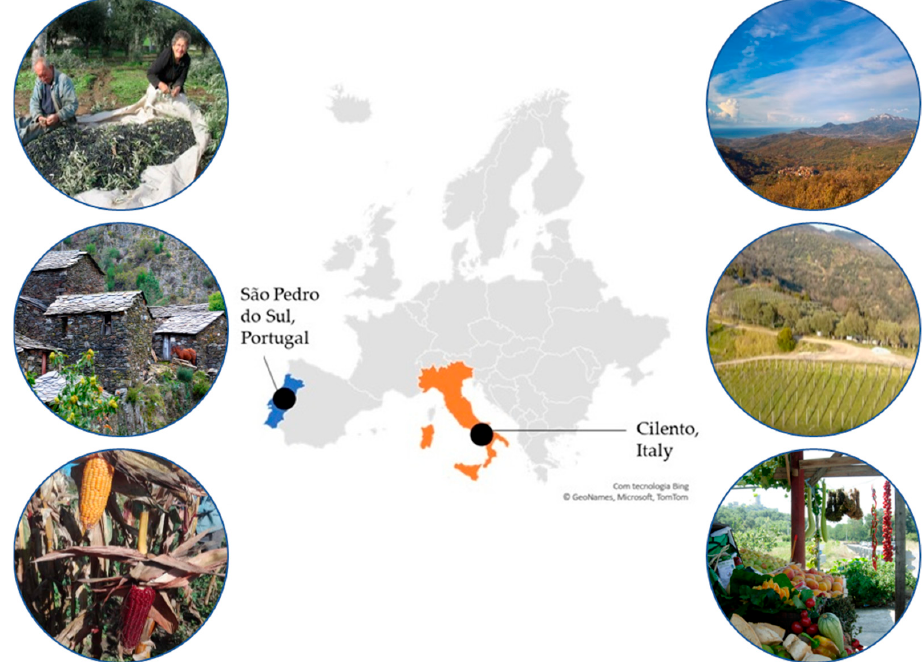
Figure 1. Cultural, technical and environmental diversity in two European Eco-regions—Cilento, Italy and São Pedro do Sul, Portugal. Table 1. Comparison of some characteristics of the Cilento and São Pedro do Sul.